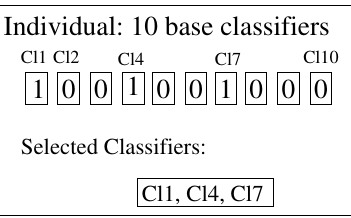
Figure 3. The combinations of base classifiers as the estimation of distribution algorithm (EDA)